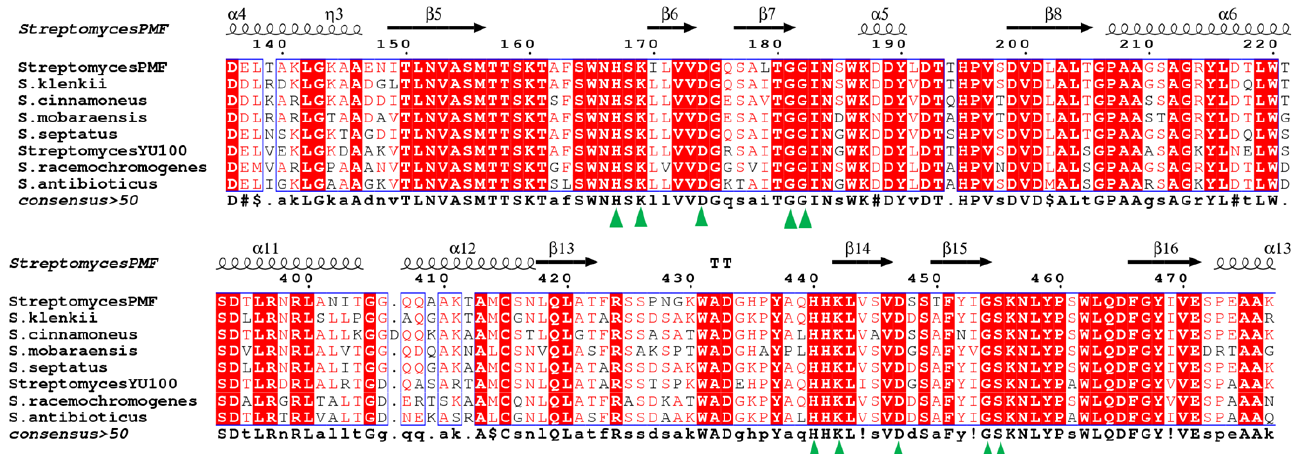
Figure 1. Multiple amino acid sequence alignment of SkPLD conserved region with several other Streptomyces PLDs. Secondary structures of PLDs were shown above the alignments. Residues highlighted in red background were indentical among the protein compared. Residues in the conserved HxKxxxxDxxxxxxGG/S (HKD) motifs of the PLD superfamily were indicated with green triangles. Arrow stands for β -strand, helical curve denotes α -helix.